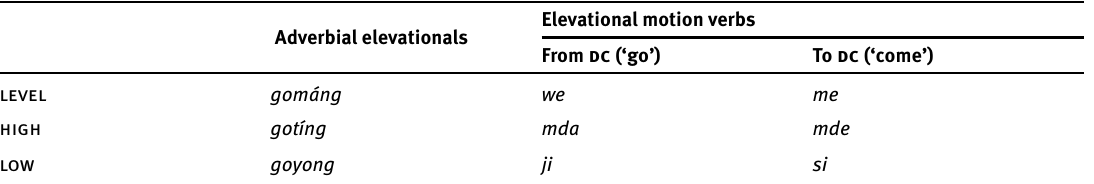
Table 1. Verbal and adverbial elevationals in Kula